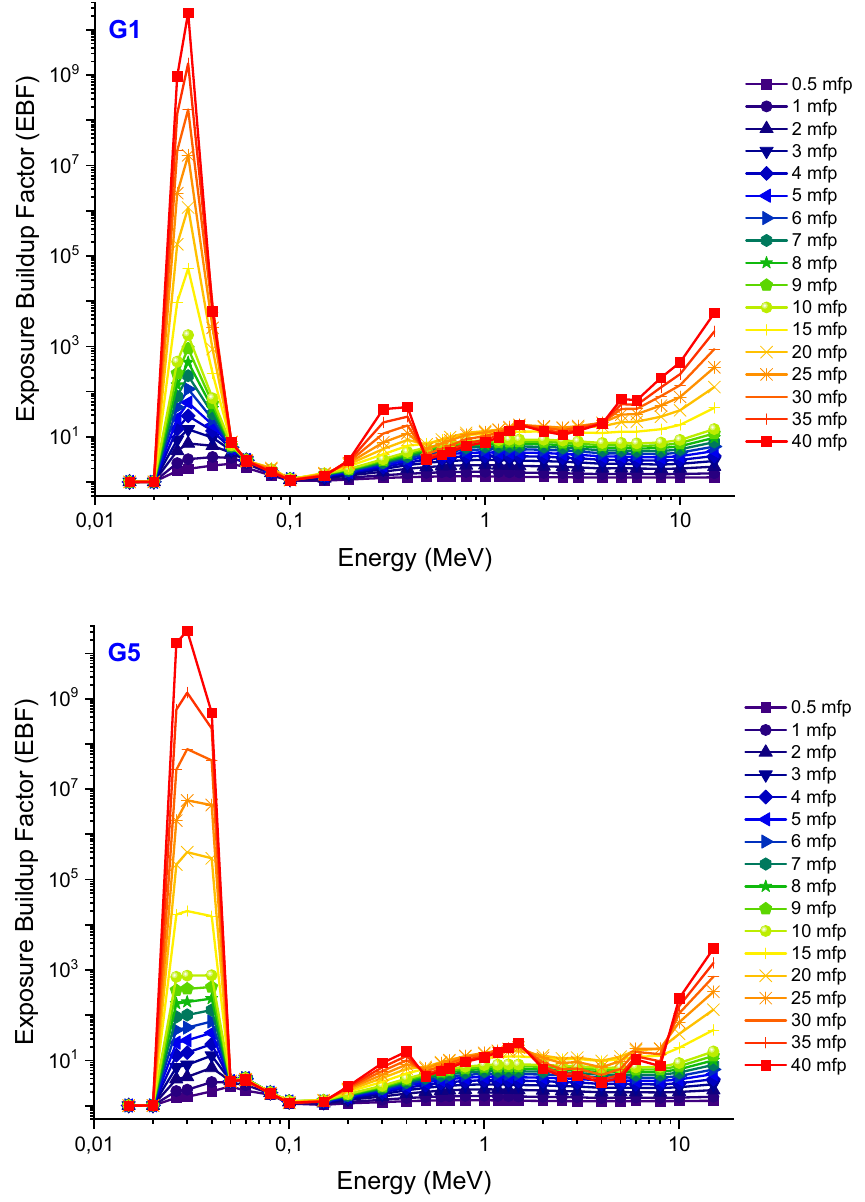
Figure 10: Variation of EBF of G1 and G5 glasses at di ff erent mean free path